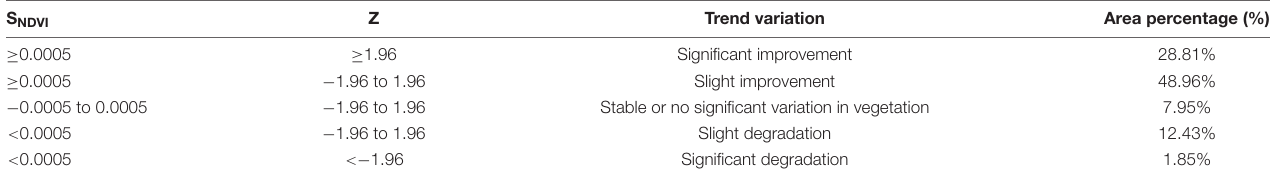
TABLE 2 | Normalized difference vegetation index (NDVI) trend variations in Guizhou